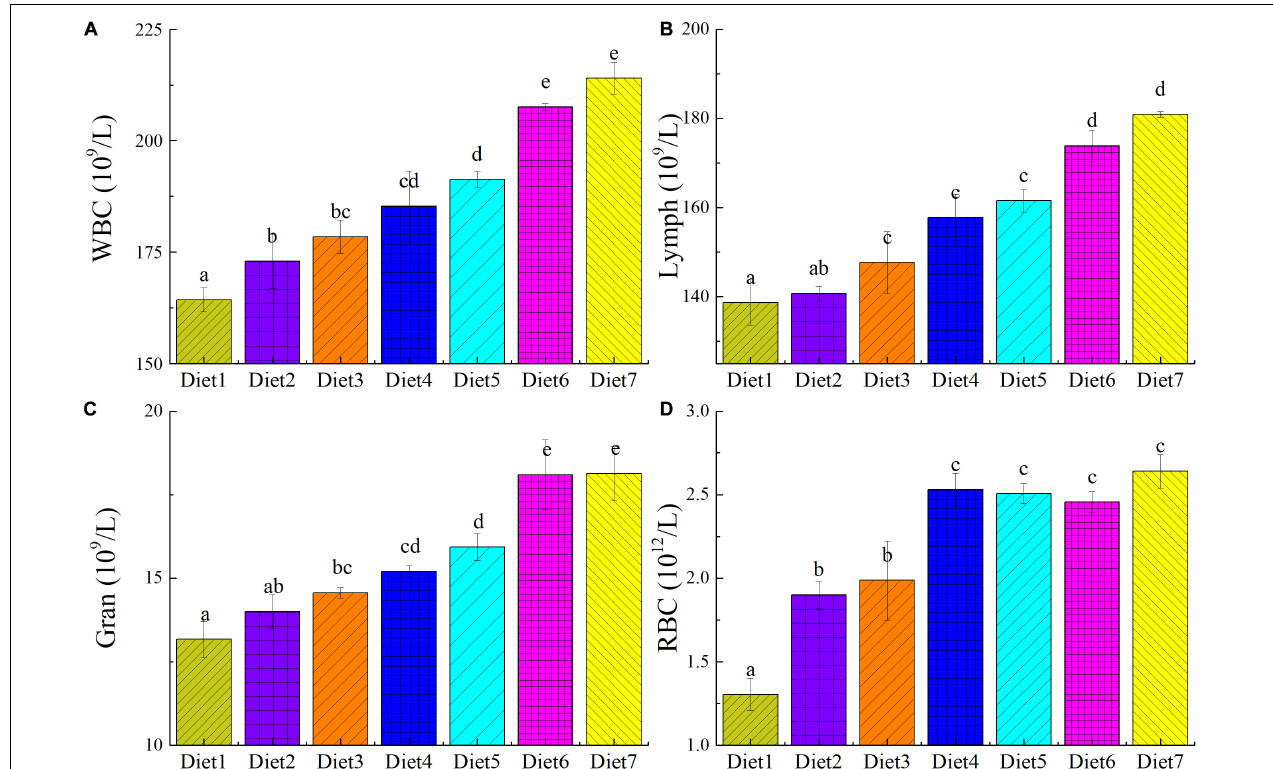
FIGURE 3 | The blood cell count of T. ovatus sp. fed diets with different levels of n -3 PUFAs Diet1 ∼ 7 for Fish feed with different n -3 PUFAs contents in 7 groups. The number of white blood cells (A) , lymphocyte (B) , granulocyte (C) , and red blood cells (D) in blood. The amount of Aurantiochytrium sp. powder in feed is